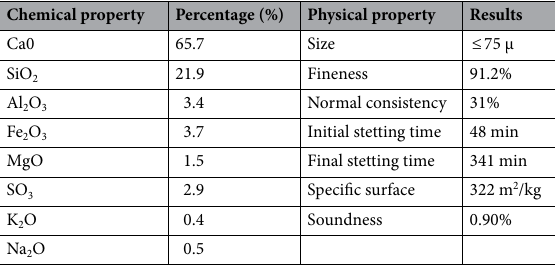
Table 1. Physical and chemical property of OPC.